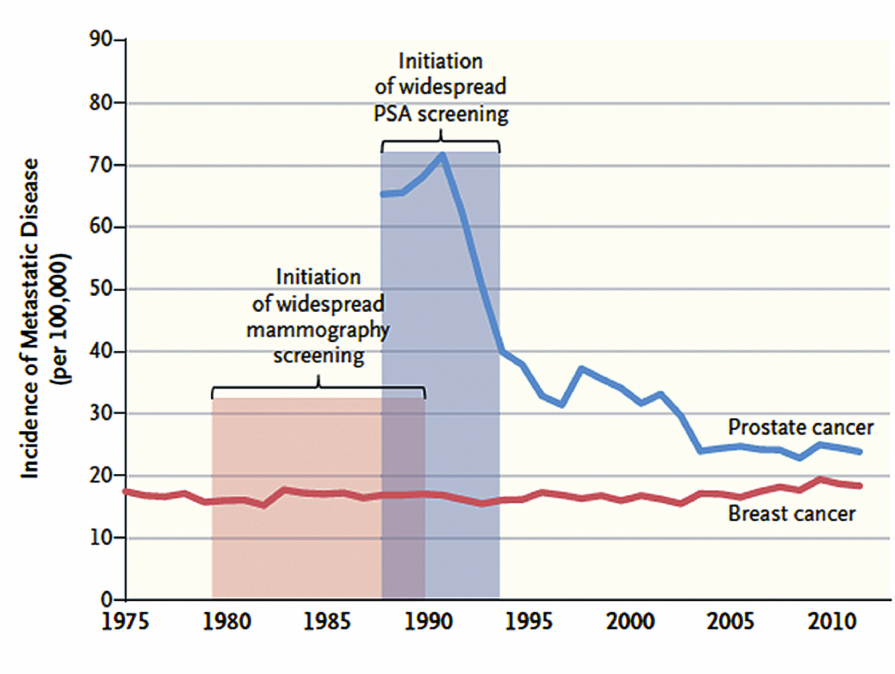
figure 2 - incidence of metastatic cancer at diagnosis, usA, 1975-2012.